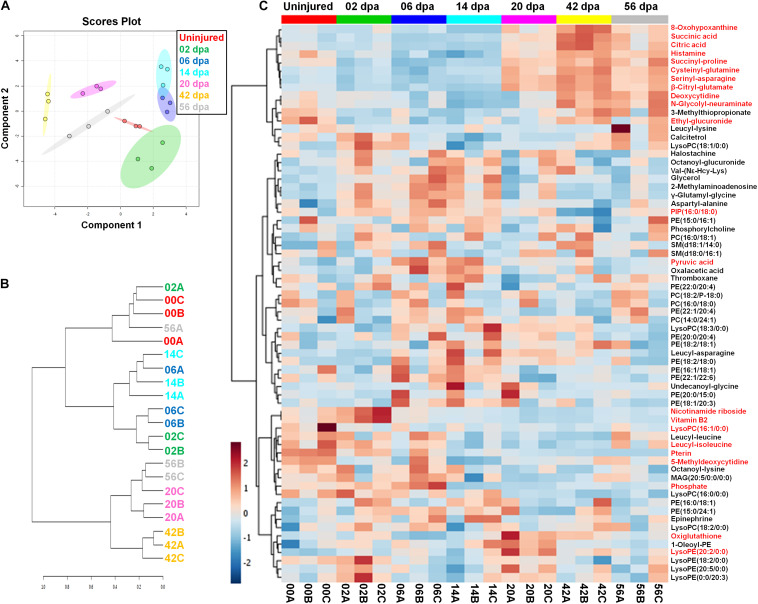
Metabolic profiling during the regeneration process. (A) Clustering of metabolite samples evaluated by Sparse Partial Least Squares-Discriminant Analysis (sPLS-DA) with 5-fold Cross-Validated threshold. The stages are highlighted in different colors, displaying regions with a 95% confidence for samples grouped. (B) Hierarchical clustering dendrogram for metabolite samples analyzed through a Spearman distance measure and Ward clustering linkage. The stages are shown with different colors. (C) Heatmap of normalized abundances for pre-identified metabolites during regeneration. The metabolite abundances highlighted in red have a P < 0.05; one-way ANOVA with post hoc Tukey–Kramer test vs uninjured condition. Hierarchical clustering of metabolites was made using a Euclidean distance measure and the Ward clustering algorithm.